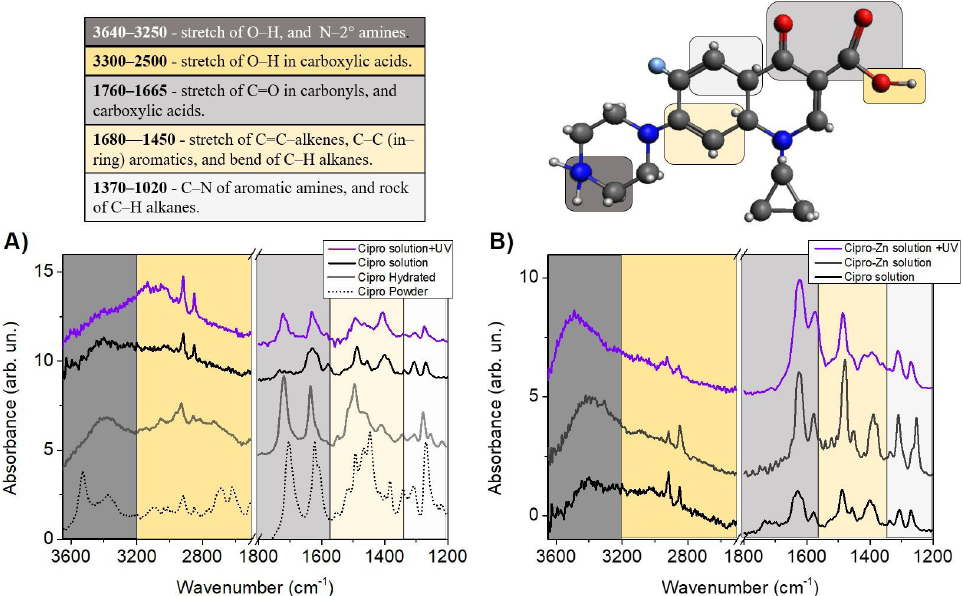
Figure 7. FTIR spectra of CIPRO exposed to UV irradiation under different conditions. A) FTIR spectra of CIPRO as powder (gray dotted line), paste (gray line), aqueous solution, and in aqueous solution after UV-irradiation (violet line); B) FTIR spectra of CIPRO aqueous solution (black line), as Zn complex before (gray line) and after 2 h of UV irradiation (violet line). The spectra panels are colored to a delimited spectral range associated to vibrations of the functional groups. In the molecular structure of CIPRO, the functional groups are indicated by the corresponding